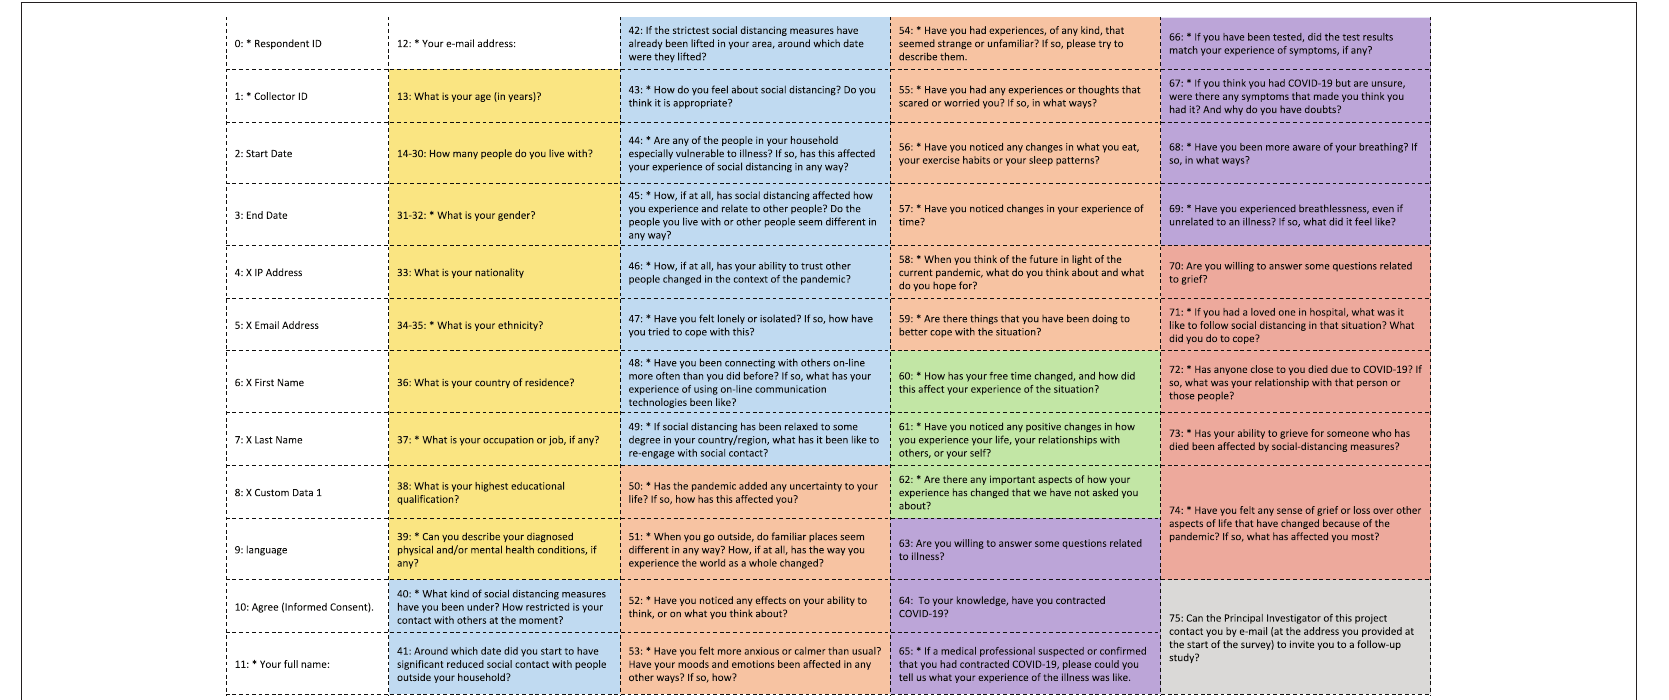
FIGURE 1 | Summary of all the data fields of the “experiences of social distancing during the COVID-19 pandemic” online survey. Fields that are prefixed with a * allowed content that was not restricted to predetermined